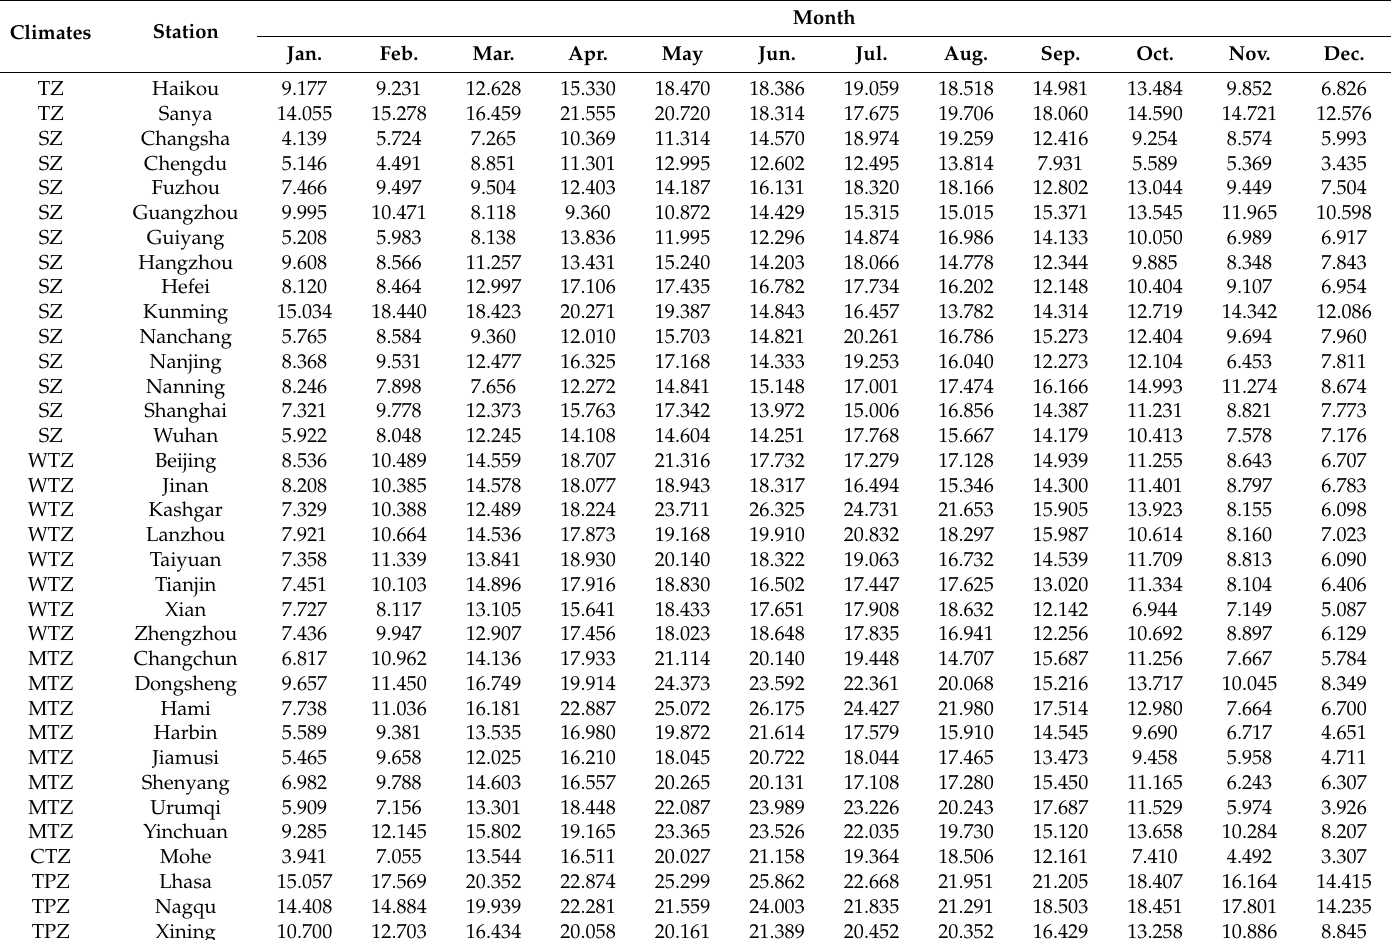
Table A1. Summary of monthly mean solar radiation data of 35 cities in six different climatic zones of China from the TMYs using the synthetic